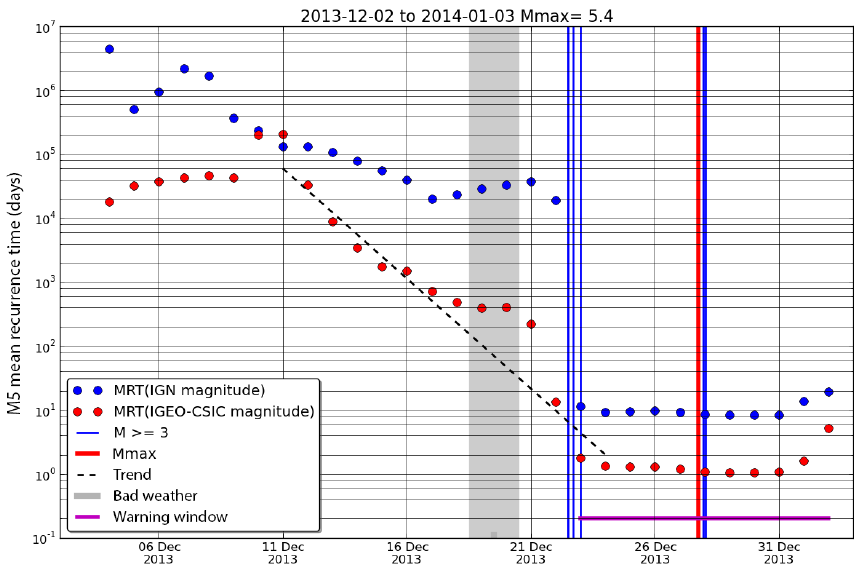
Figure 7. MRT evolution (computed using MLE) in December 2013 calculated from the IGN official catalogue (blue) and from the IGEO- CSIC catalogue (red). The magnitude of the earthquake on 27 December 2013 17:46:02 was estimated by IGN as 5.1, and as 5.4 by the IGEO-CSIC network and other international